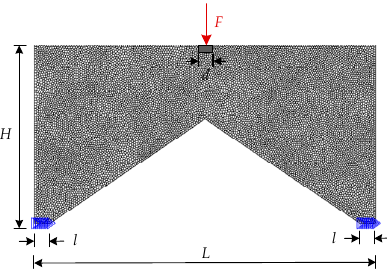
Figure 12. Design domain and boundary conditions for a portal frame.